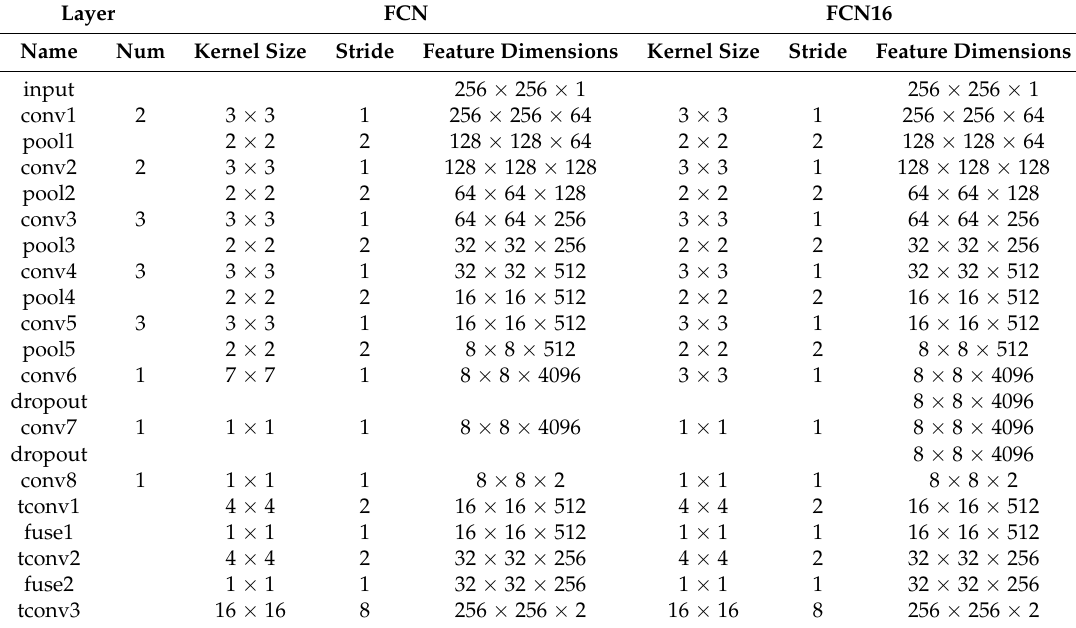
Table 2. Comparison of structures between FCN and FCN16 (The column Num in Layer is the number of convolutions in convolution